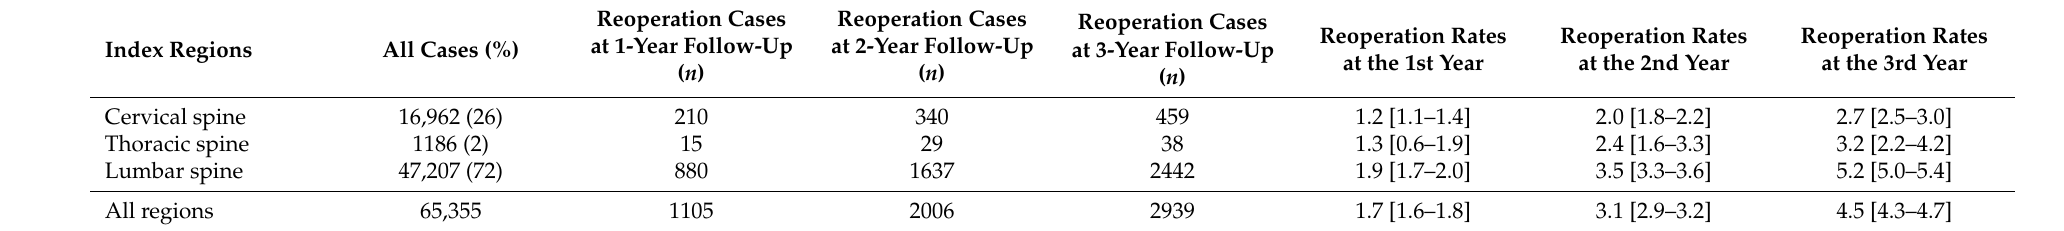
Table 1. Annual reoperation rates according to the spinal regions.